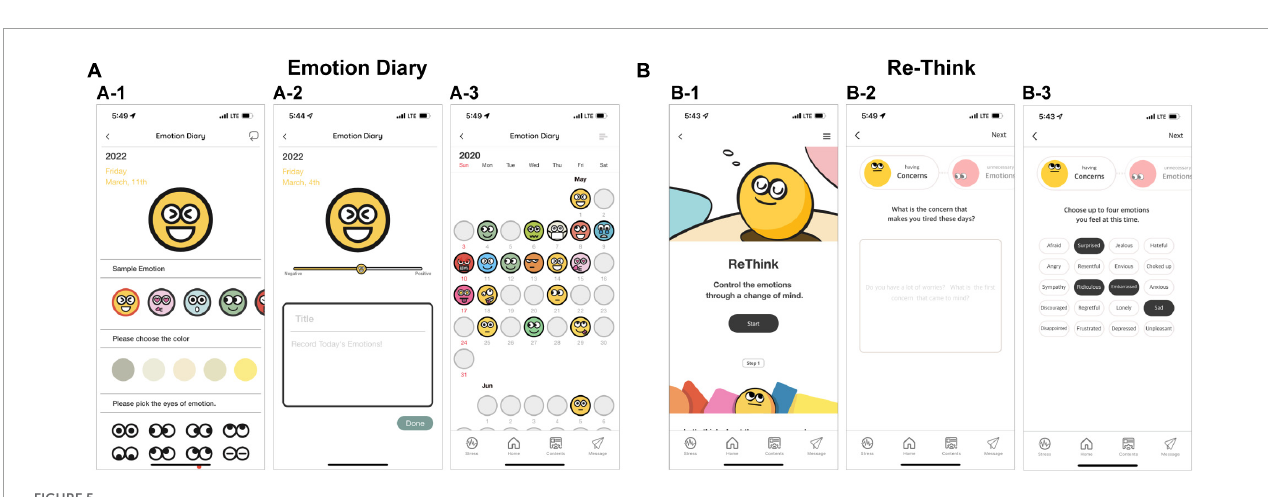
FIGURE5 Screenshots of the cognitive approach module. The module includes two parts ( A : “Emoji and Emotion Diary” and B : “Re-Think”). Emoji is a tool for expressing varied emotions; the participant can choose what is presented as a sample or create their own Emoji by selecting a color or shape such as eyes and mouth (A-1). The diary is created by checking the emotional intensity related to the previously created Emoji through the slider and entering the title and details (A-2). Participants can see the content of their diary and the emoji of any particular day through the calendar (A-3). In all steps in the “Re-Think” part, participants write answers to the questions displayed on the screen (B-2), and select emotion cards (B-3). The content was presented in Korean, but the examples in this figure are presented in English to aid understanding for international